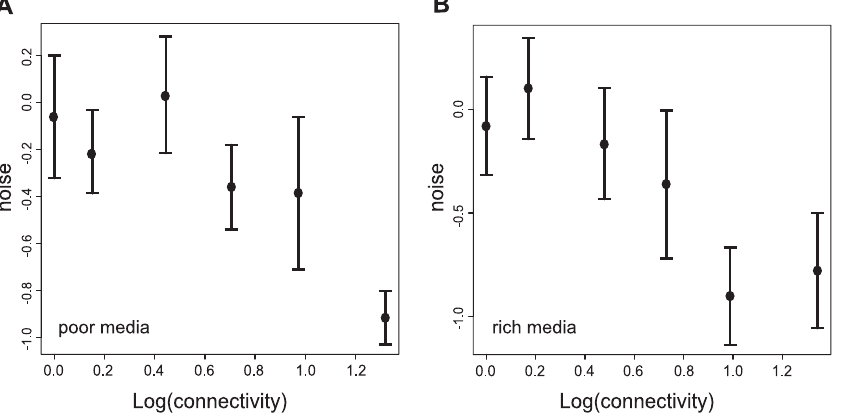
Figure 7. More Highly Connected Proteins Exhibit Less Noise Under both nutrient-poor (A) and nutrient-rich (B) conditions, more-connected proteins show less noise in their prevalence at the single cell level [43] when controlled for absolute protein abundance levels. For these plots, the data were split in to equal-sized bins of approximately equal connectivity. The values on the x -axis indicate the mean log connectivity of each bin. DOI: